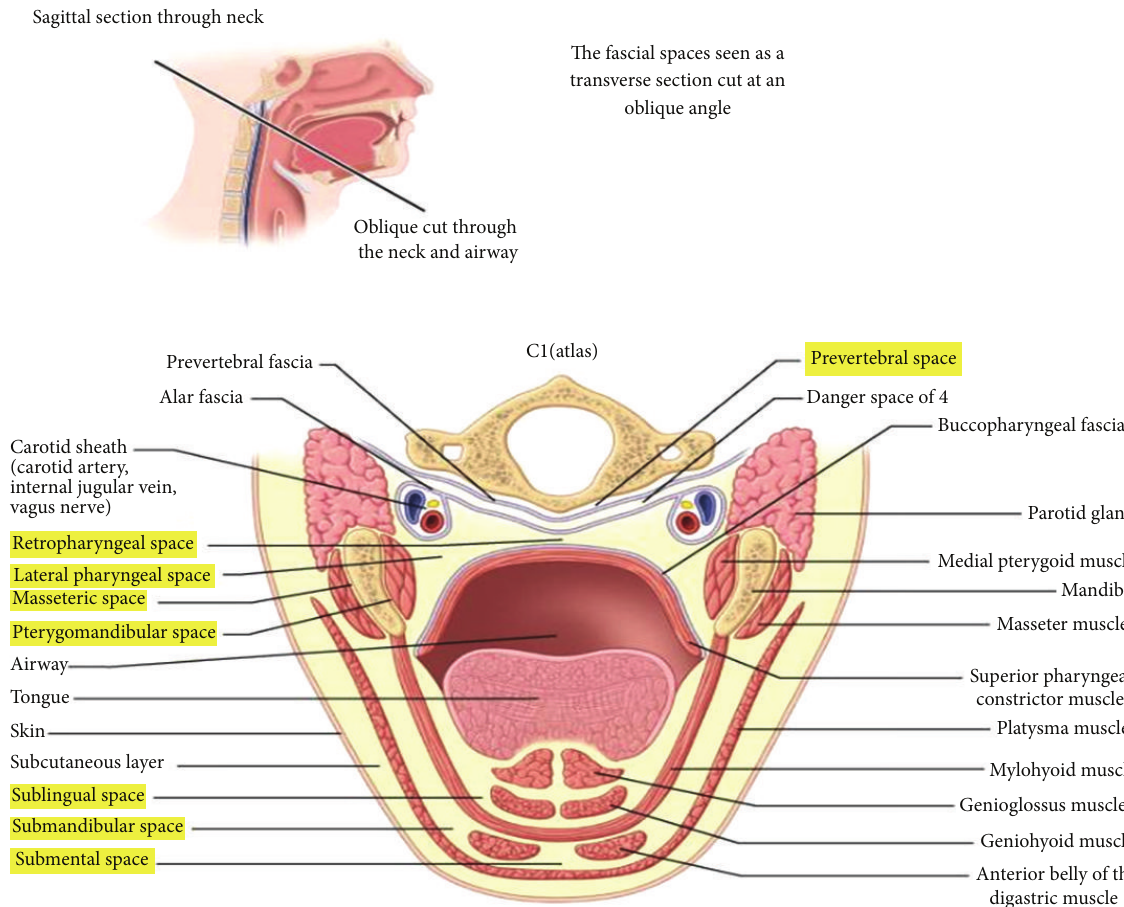
Figure 7: Close proximity of the posterior mandible to the prevertebral spaces which can lead directly to the mediastinum. (Taken from